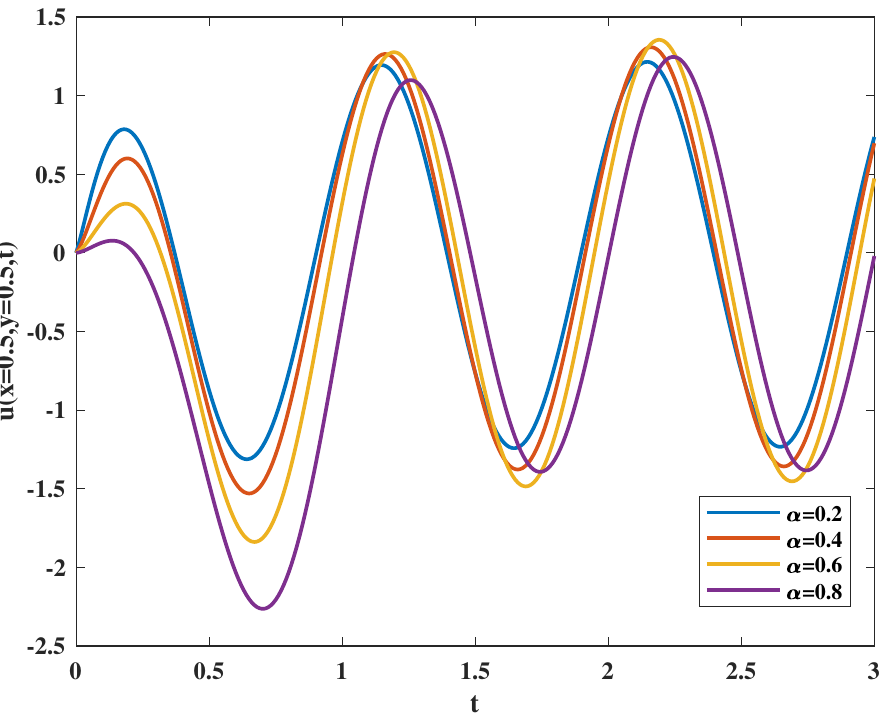
Figure 4. Velocity varies with fractional parameter α